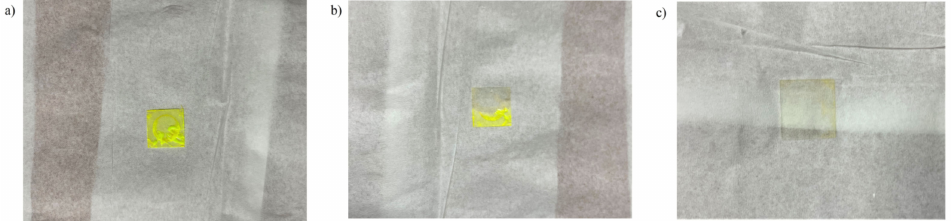
Figure 8. PVP-based green fluorescent film: ( a ) morphology after film formation, ( b ) partial immer- sion in water, and ( c ) complete immersion of the fluorescent film in